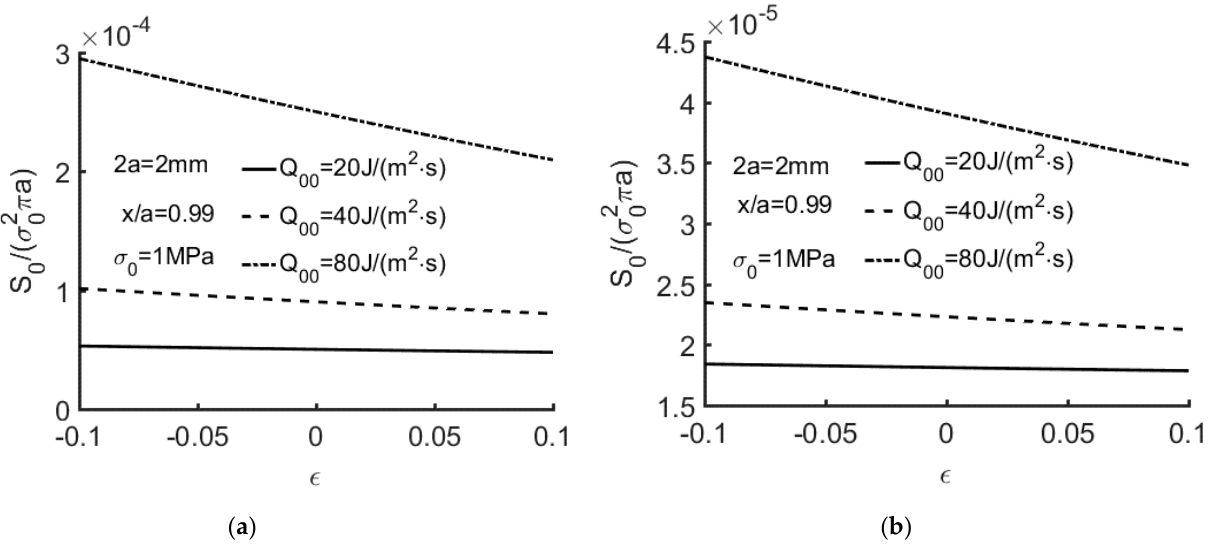
Figure 13. ( a ) S 0 /( σ 02 π a ) versus ε with Q 00 = 20, 40, 80 J/(m 2 · s) for Ec = 1. (2 a = 2 mm, x/a = 0.99, σ 0 = 1 MPa). The orthotropic material listed in Table 1. ( b ) S 0 /( σ 02 π a ) versus ε with Q 00 = 20, 40, 80 J/(m 2 · s) for E c = 1. (2 a = 2 mm, x/a = 0.99, σ 0 = 1 MPa). The isotropic material listed in Table